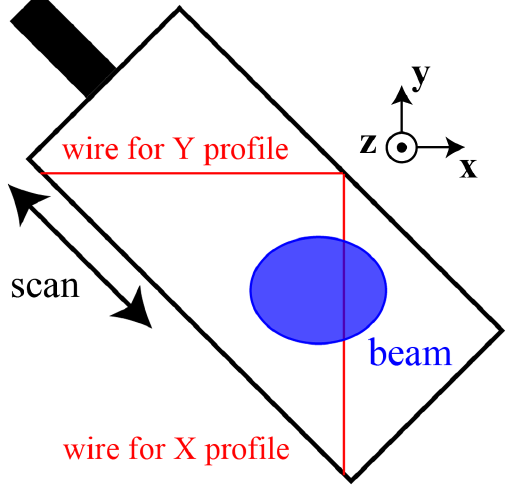
FIG. 11. A schematic diagram of a wire scanner monitor. The wire is made of carbon nanotubes and the wire diameter is 100 μ m.